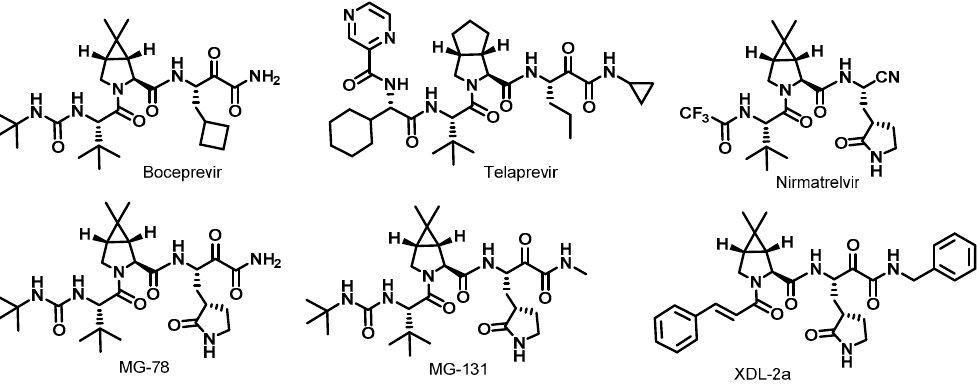
Figure 1. Chemical structures of viral protease inhibitors. Boceprevir and telaprevir show moderate and weak inhibition, respectively, against the SARS-CoV-2 M pro . The crystal structures reveal an overall acceptable fit between the drugs and the M pro but also less-than-ideal interactions and, in the case of telaprevir, costly conformational changes that are likely responsible for the reduced inhibitory